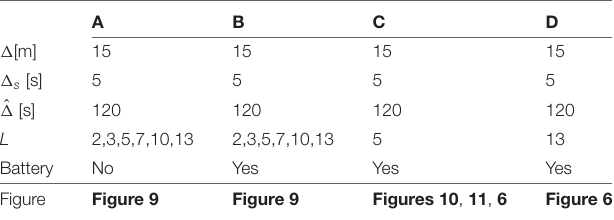
TABLE 2 | Parameter values for experiments (see Table 1 for symbol